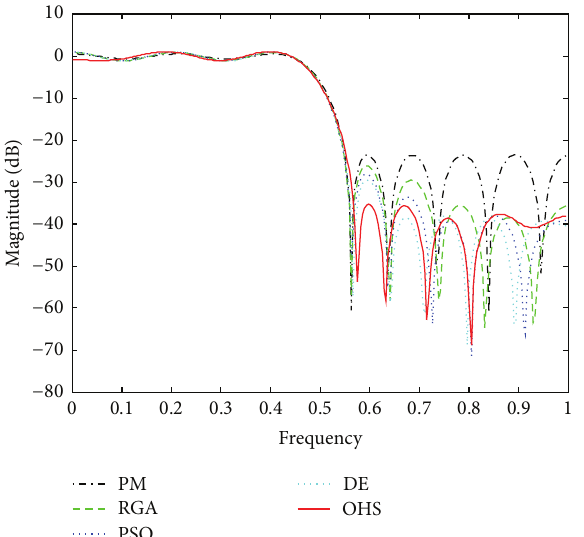
Figure 2: Normalized plots for the FIR LP filter of order 20.